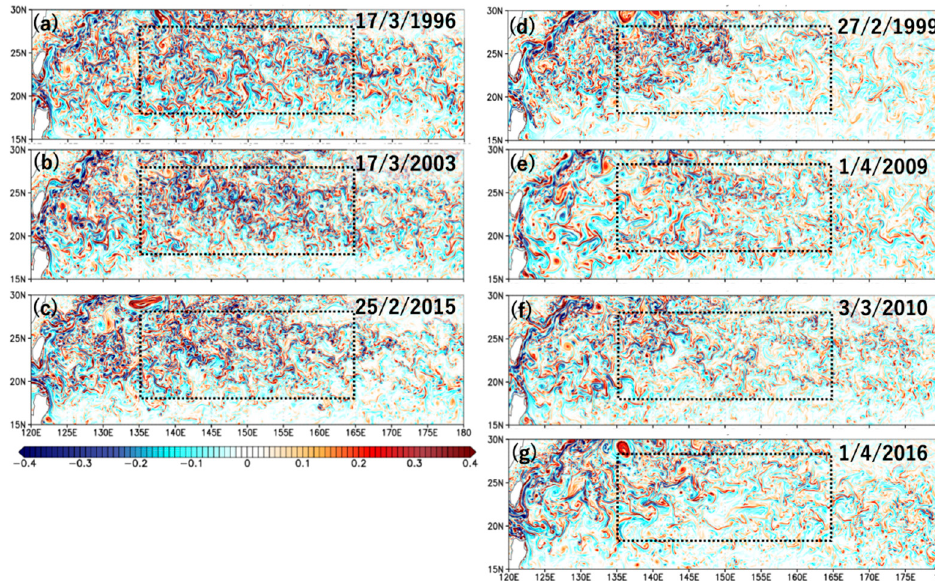
Figure 3. Surface relative vorticity (1×10 − 4 s − 1 ) in the subtropical Northwestern Pacific on the day with maximum relative vorticity RMS in the STCC region (box area) in each year. The submesoscale motions are active in the left figures on ( a ) 17 March 1996, ( b ) 17 March 2003, and ( c ) 25 February 2015 and calm in the right figures on ( d ) 27 February 1999, ( e ) 1 April 2009, ( f ) 3 March 2010, and ( g ) 1 April 2016. The box region corresponds to the STCC region.